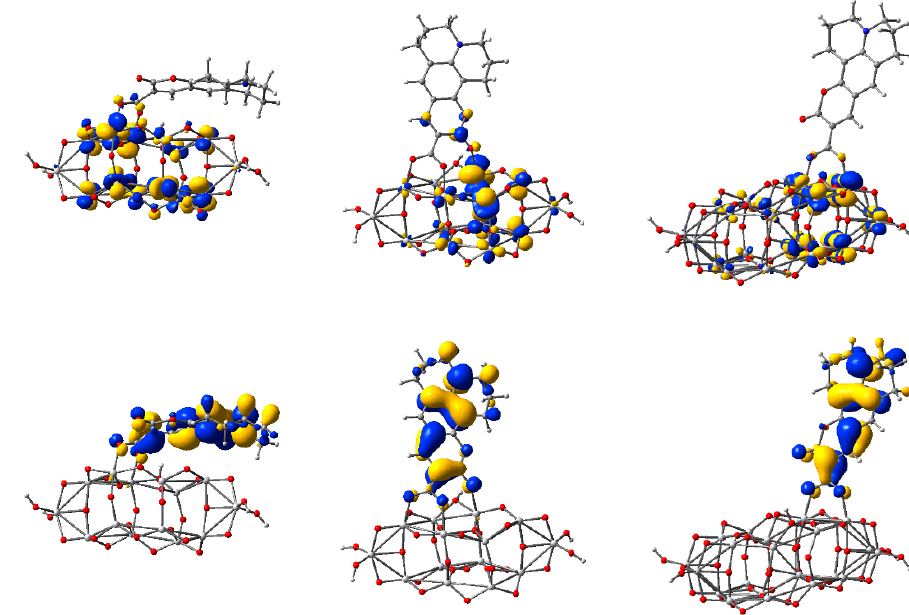
Figure 10. Isodensity surfaces (0.03 e/bohr 3 ) of the key molecular orbitals of the systems consisting of the C343 molecule adsorbed on the Ti 14 O 30 H 4 cluster via two ( left column ) or three ( middle column ) O–Ti bonds and on the Ti 24 O 50 H 4 cluster ( right column ), calculated by DFT at the B3LYP/LANL2DZ level in water solvent. The first row displays the LUMOs, whereas the bottom row shows the HOMOs. Atom colors: Ti, grey; O, red; and H, light grey.